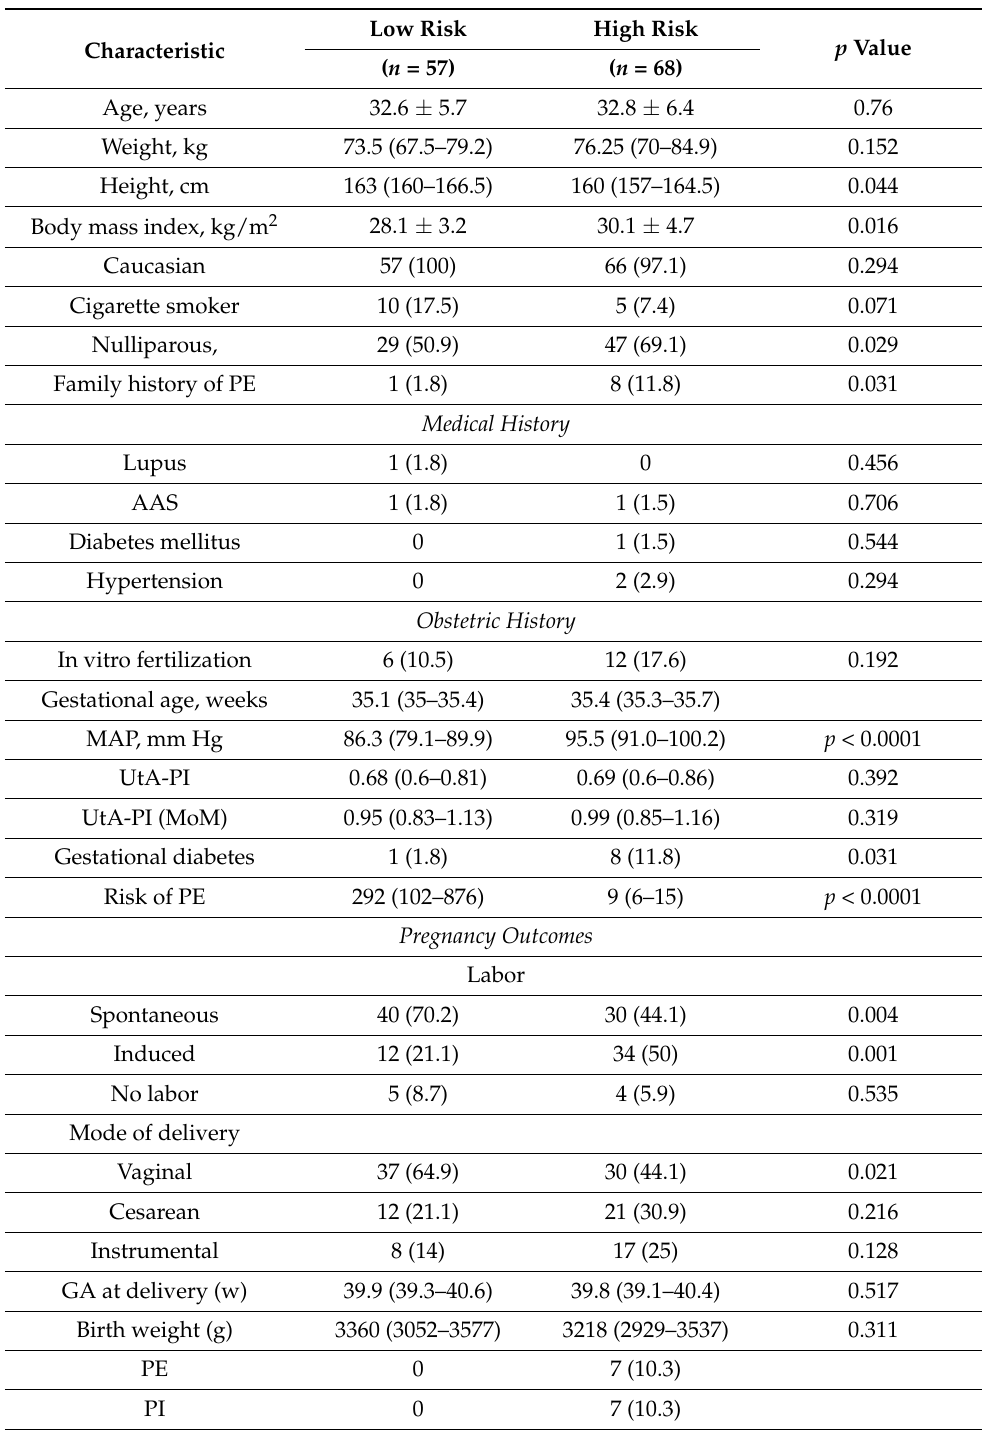
Table 1. Characteristics of the